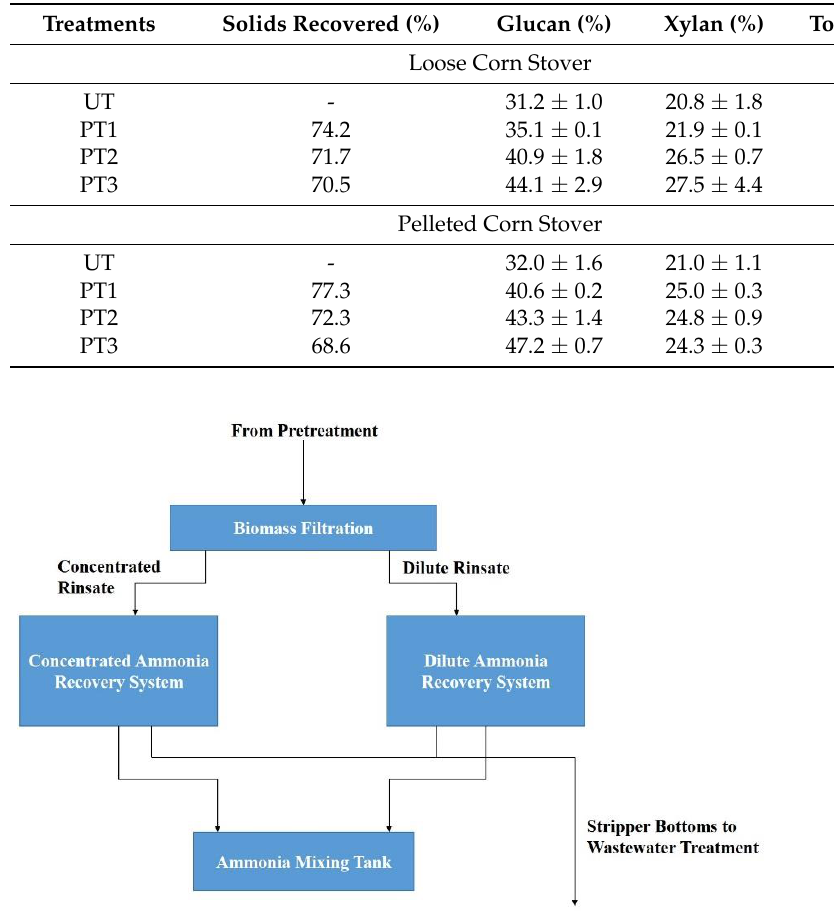
Figure A1. Details on ammonia recovery system.